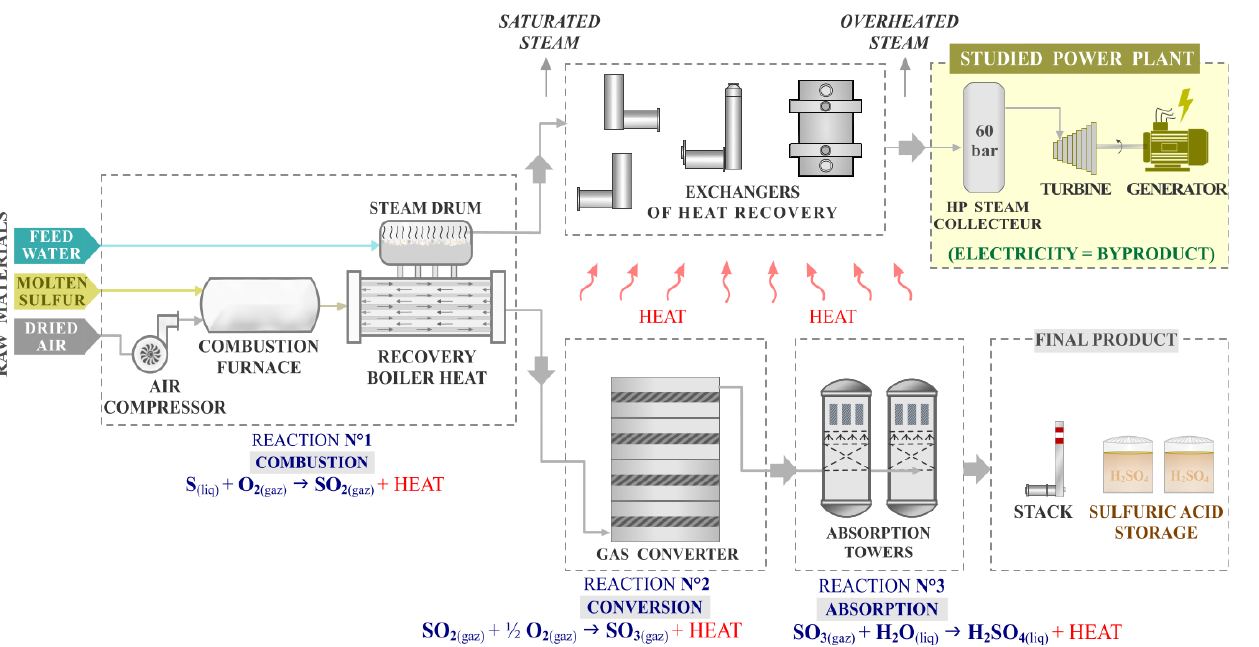
Figure 1. Overview of the process related to the co-production of sulfuric acid and electricity.